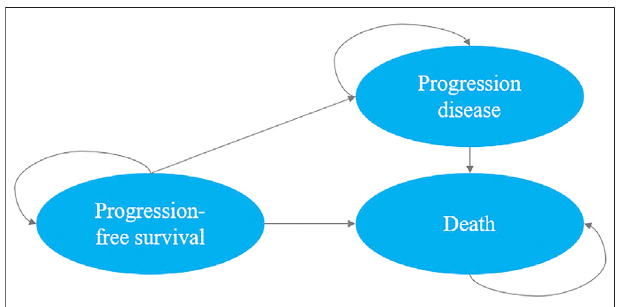
FIGURE 1 | Markov state transition